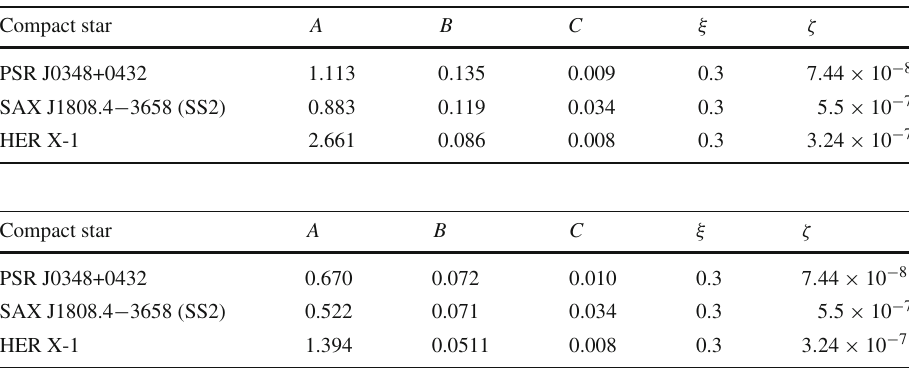
Chaplygin EoS for α = 0 ( β = 1, β 1 = 0 and γ = 1)